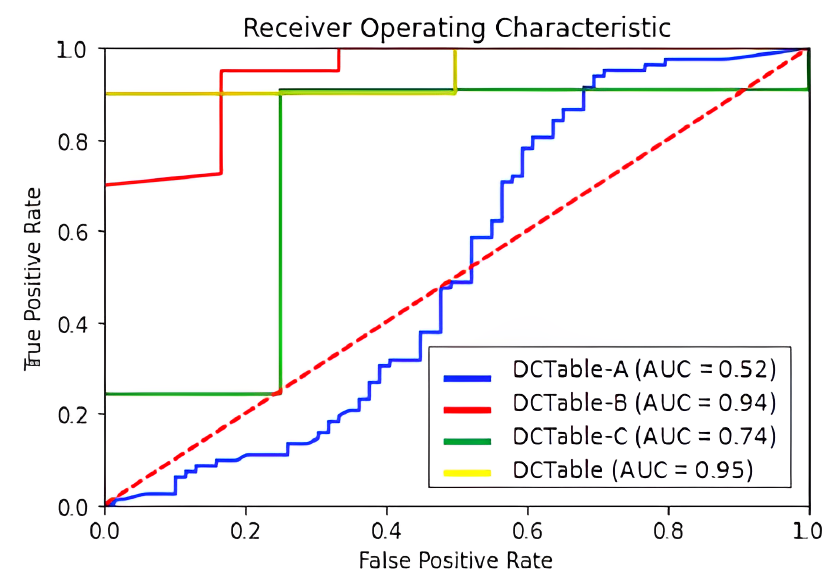
Figure 7. ROC curve for ICDAR 2017-POD